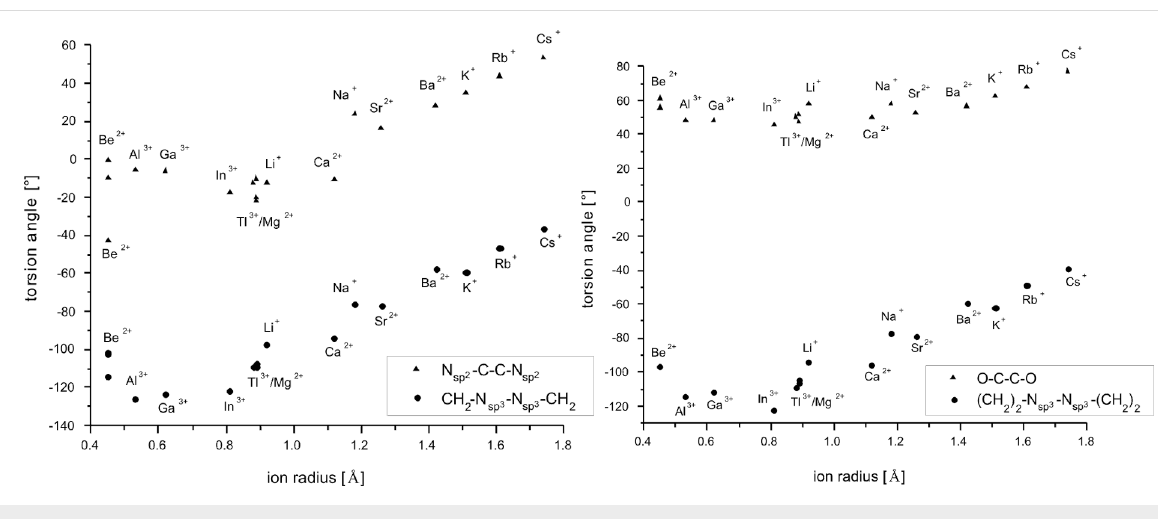
Figure 16: Reverse development of the calculated torsion angles on the respective cryptate sides for [2.bpy.bpy].